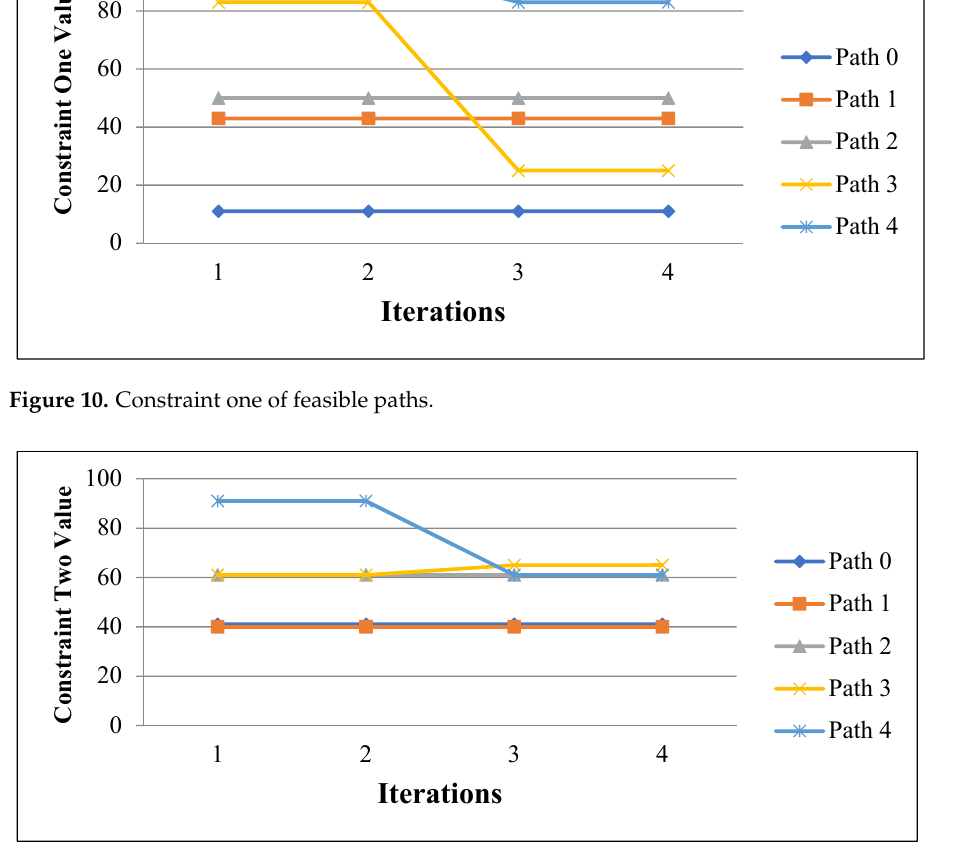
Figure 11. Constraint two of feasible paths.